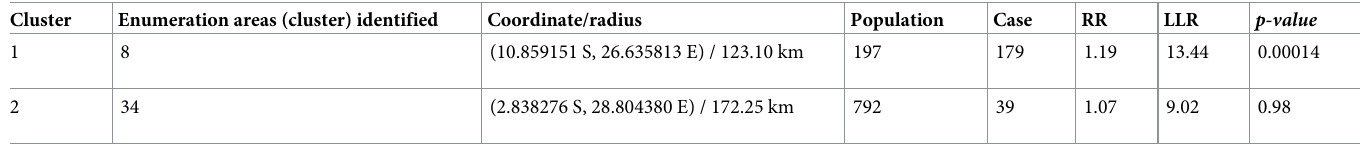
Table 3. SaTScan analysis result summary of HRFB among married women in the Democratic Republic of the Congo. Cluster Enumeration areas (cluster)